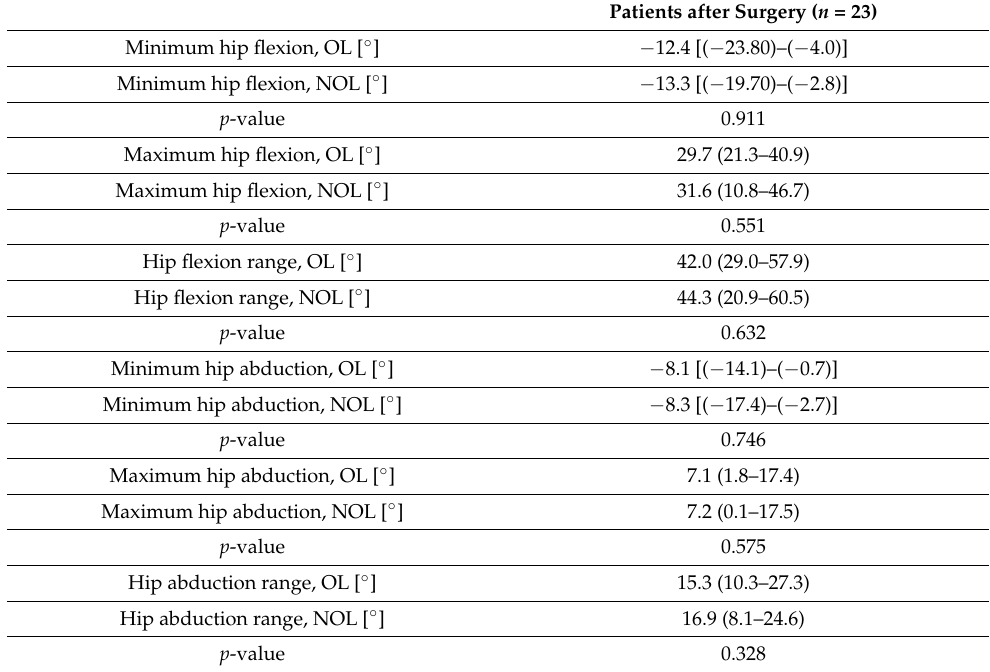
Table 1. Differences in hip flexion and hip abduction 24–48 month after Ilizarov